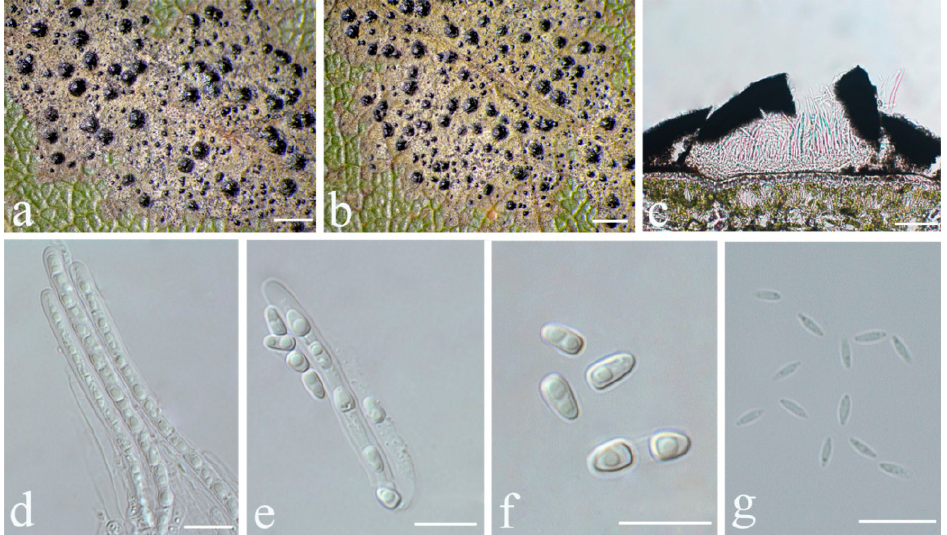
Figure 16. Strigula subtilissimoides sp. nov. ( a , b ) Thallus (holotype, HMAS–L0139253); ( c ) perithecia (HMAS–L0139255); ( d ) asci (holotype, HMAS–L0139253); ( e , f ) ascospores (holotype, HMAS– L0139253); ( g ) microconidia (HMAS–L0139255). Scale bars: ( a – c ) = 500 μ m, ( d – g ) = 10 μ m.